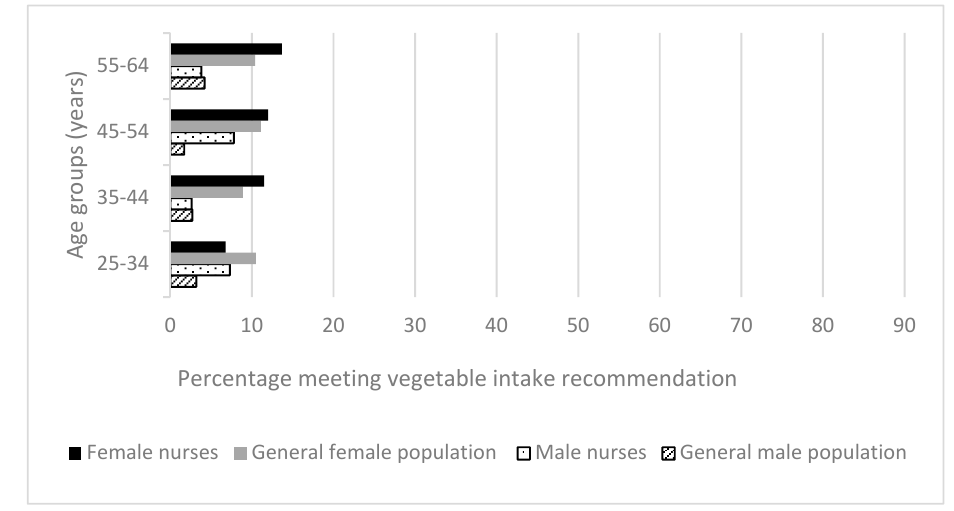
Figure 1. Health-related behaviors of nurses and midwives compared to the Australian general population 2014–2015 [28]: Vegetable intake.